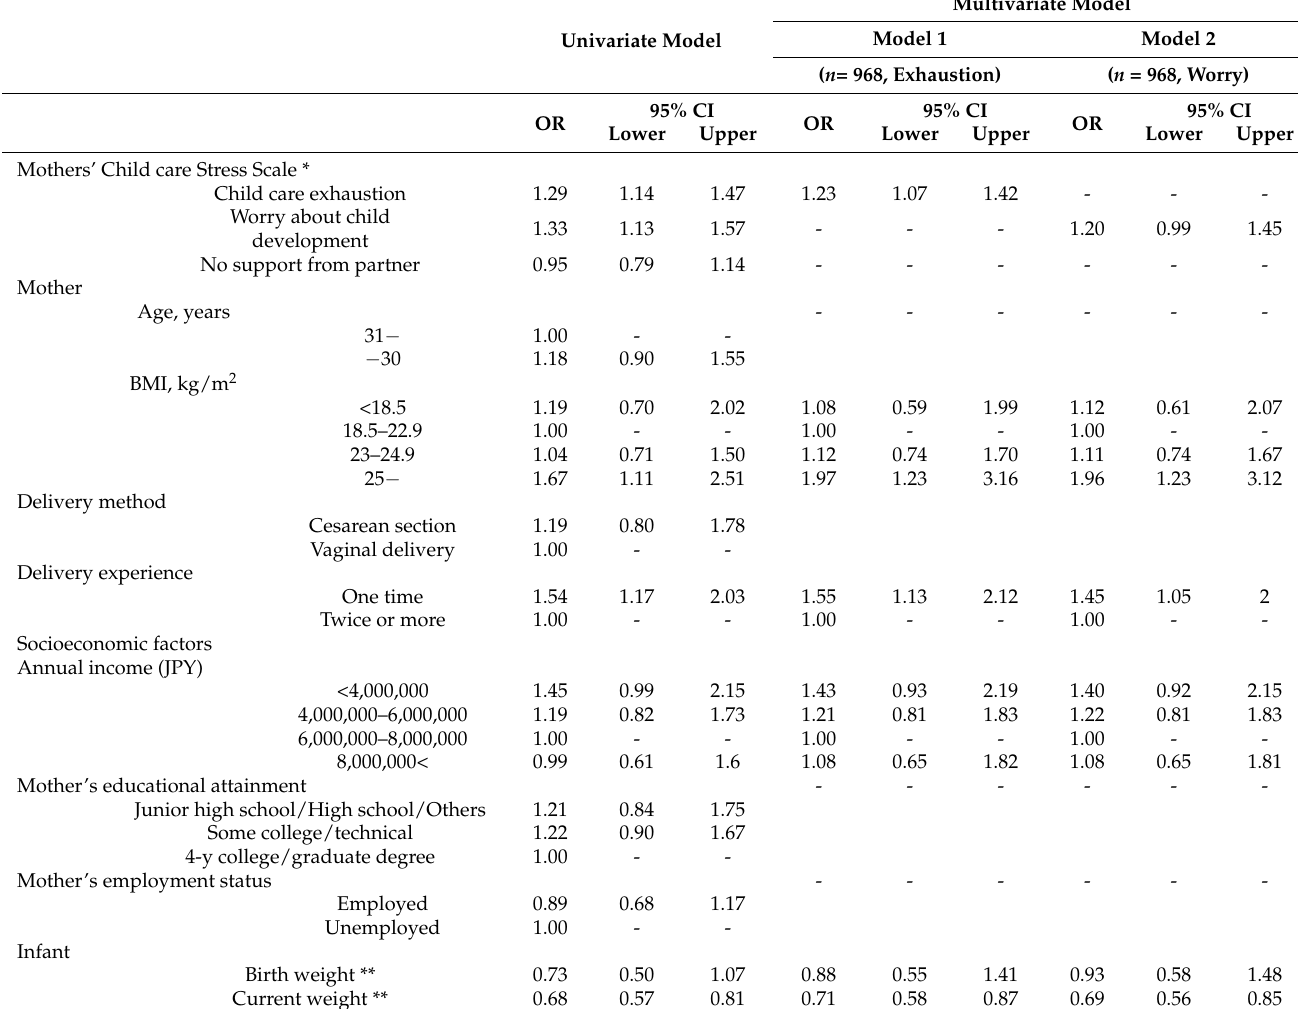
Table 3. Factors associated with partial breastfeeding at two